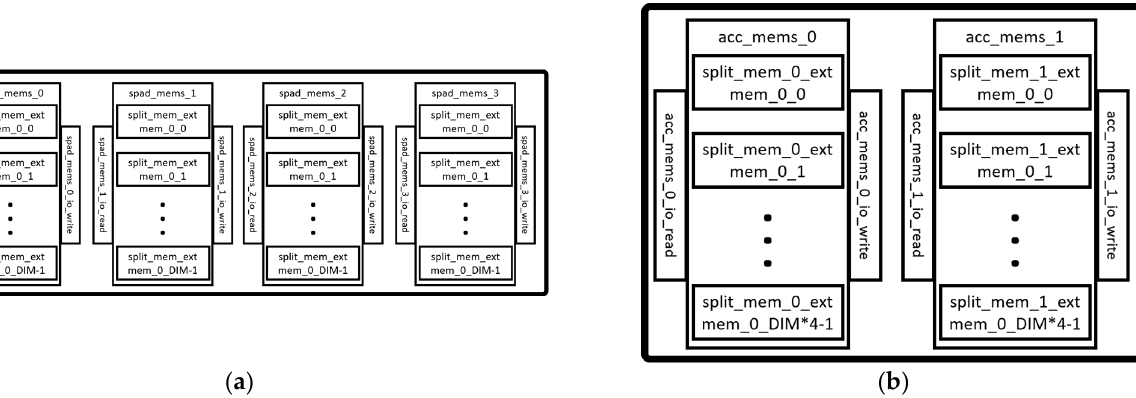
Figure 10. Scratchpad memories: ( a ) ScratchpadBank module; ( b ) AccumulatorMem module.